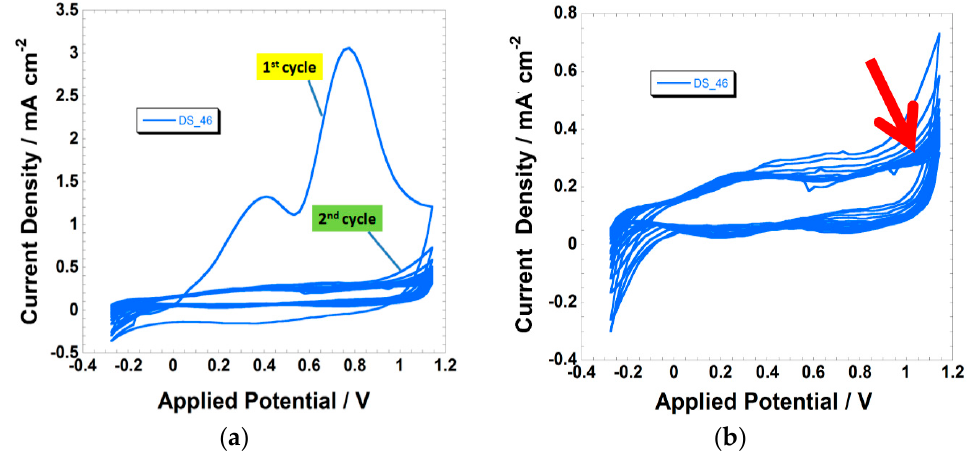
Figure 4. ( a ) First 20 voltammograms of the DS_46-sensitized NiO electrode at the scan rate of 100 mV s − 1 . The first two cycles are indicated; ( b ) Stabilization of the voltammogram of the DS_46-sensitized electrode after the first cycle, evidenced in the left frame. The red arrow indicates the sense of variation of the current profile upon the increase of the number of cycles. See Figure S2 for the visualization of the dye structure.